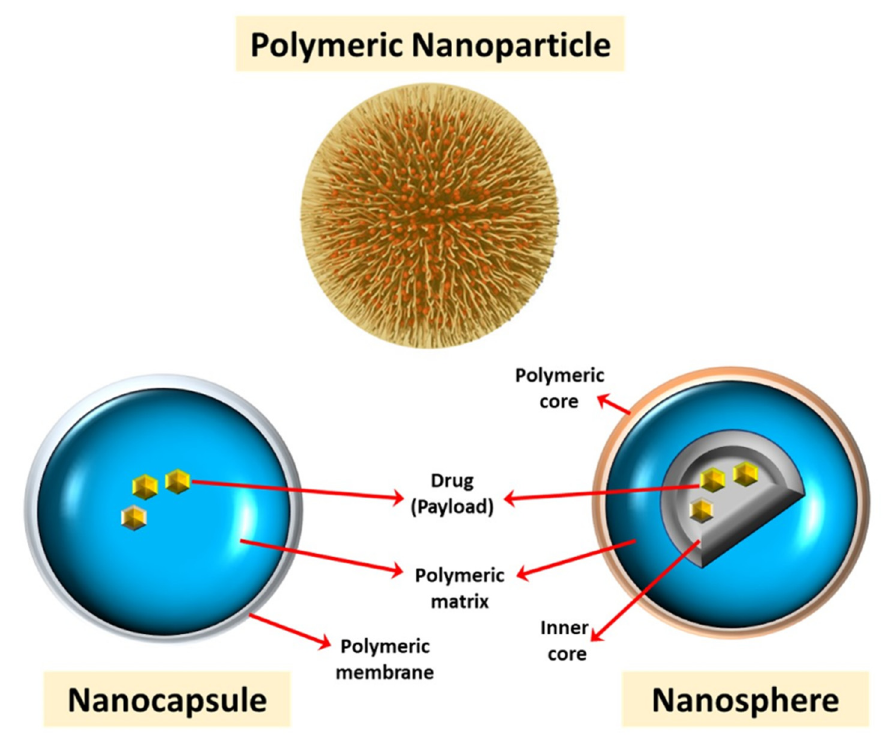
Figure 2. The role of polymeric nanoparticles on the treatment of AD.